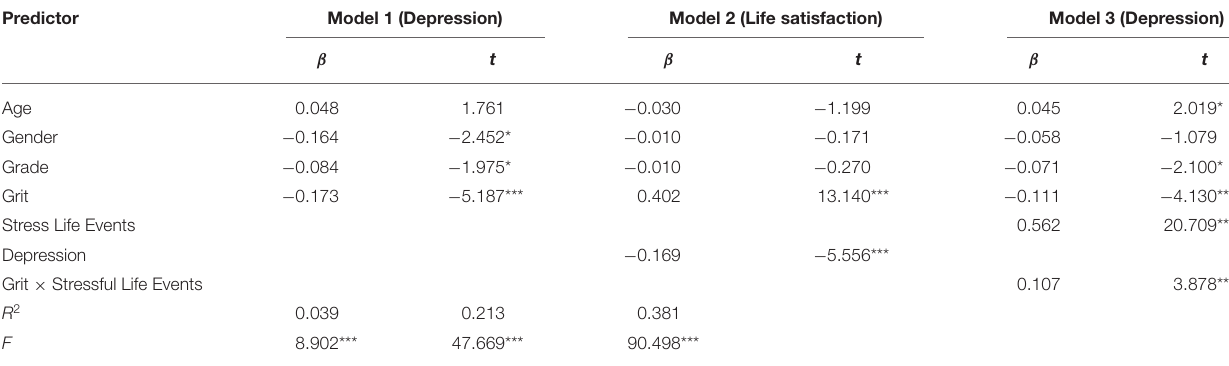
TABLE 2 | Testing the moderated mediation model.